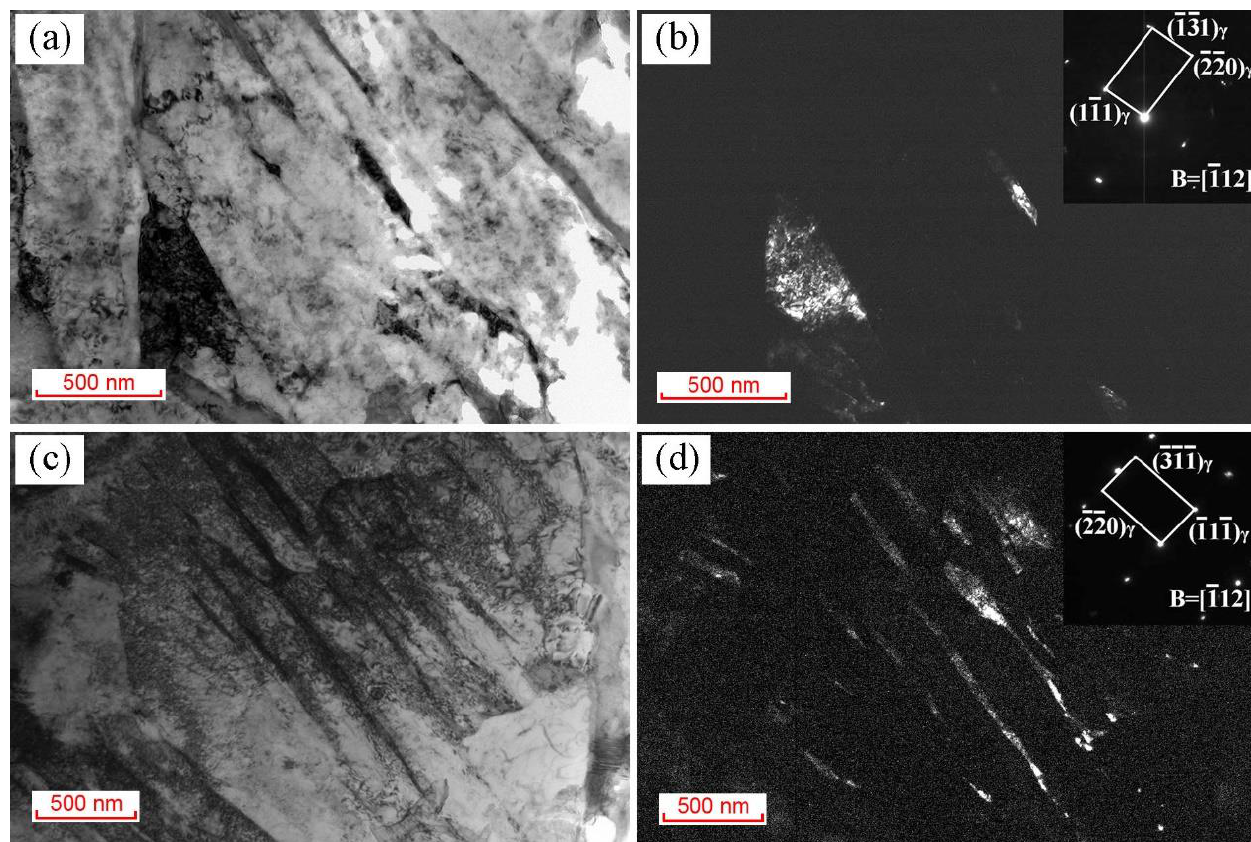
Figure 10. TEM micrographs of film-like RA after Q&P treatment: ( a , c ) bright-field images and ( b , d ) dark-field images with SEAD patterns.